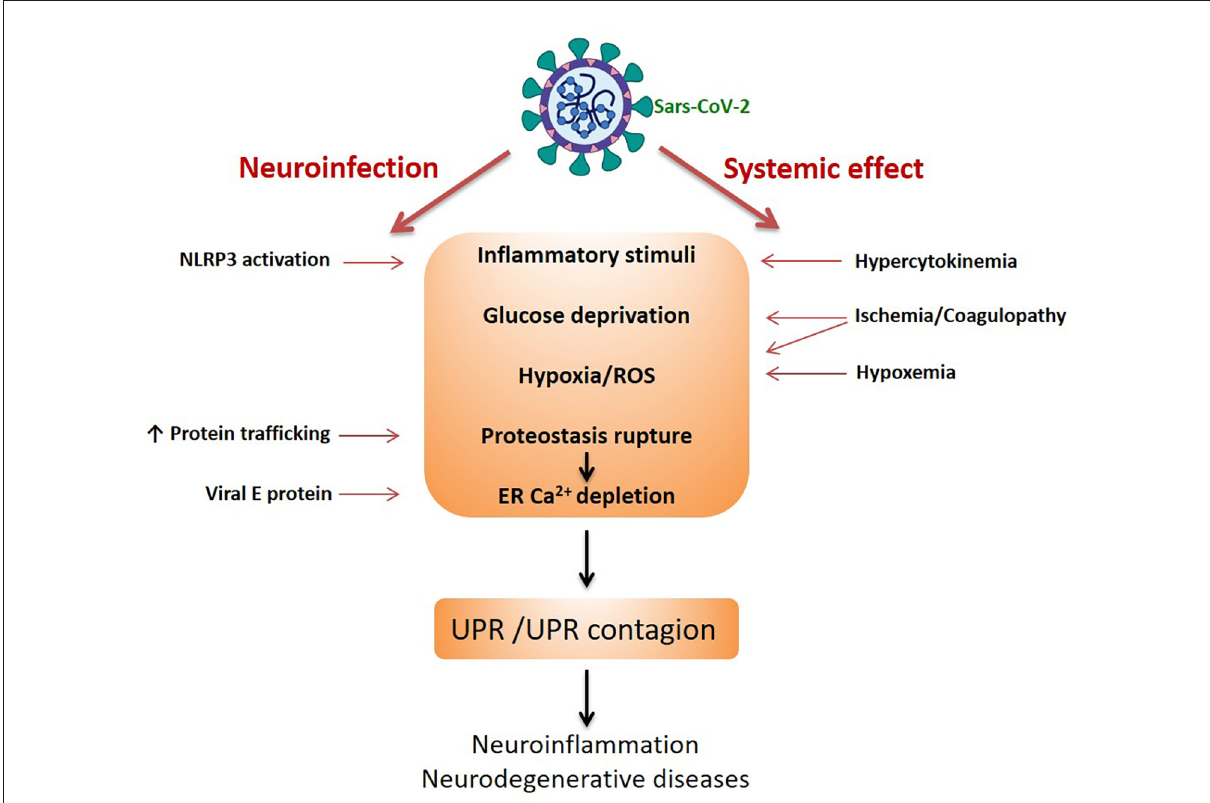
FIGURE2 Sars-CoV-2-induced UPR in neural cells. The scheme highlights the two pathways of damage to the CNS by the coronavirus, indicating the possible mechanisms triggering UPR. The UPR and the intercellular spread of the UPR (UPR contagion) would be the basis of neurodegenerative